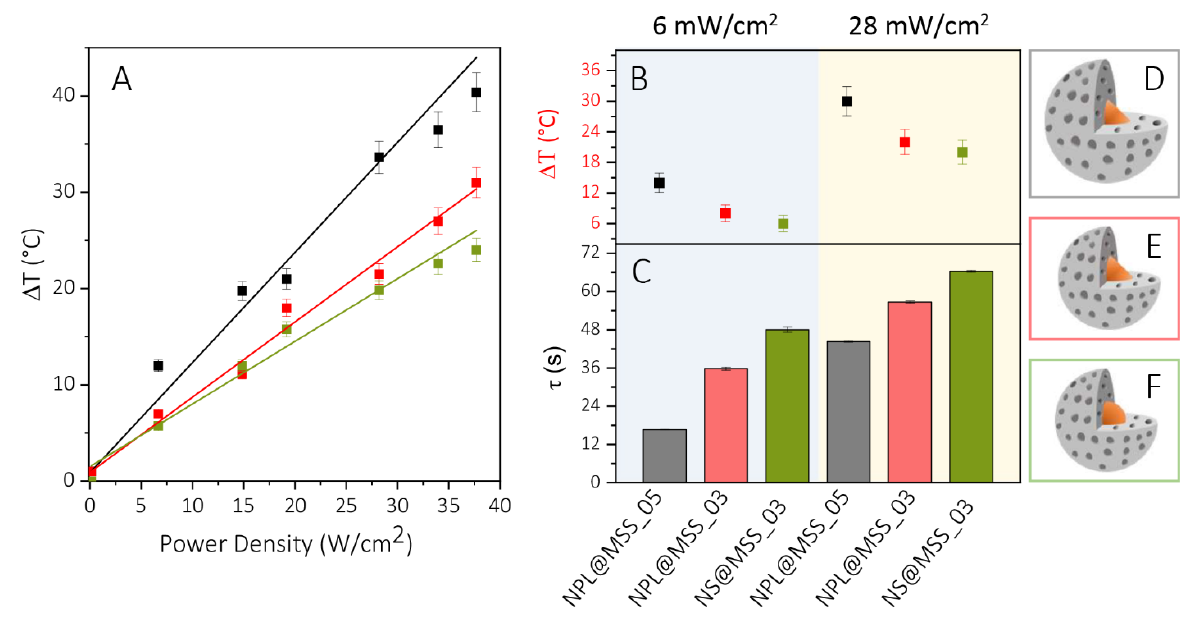
Figure 6. ( A ) Scatter plot and linear fitting of the temperature increase versus power density and ( B ) maximum temperature increase and ( C ) time constant values τ for NPL@MSS_05 (black), NPL@MSS_03 (red) and NS@MSS_03 (green). ( D – F ) Sketches of the core-shell nanostructures. Conversely, the NPL@MSS_05 and NPL@MSS_03 samples remain almost